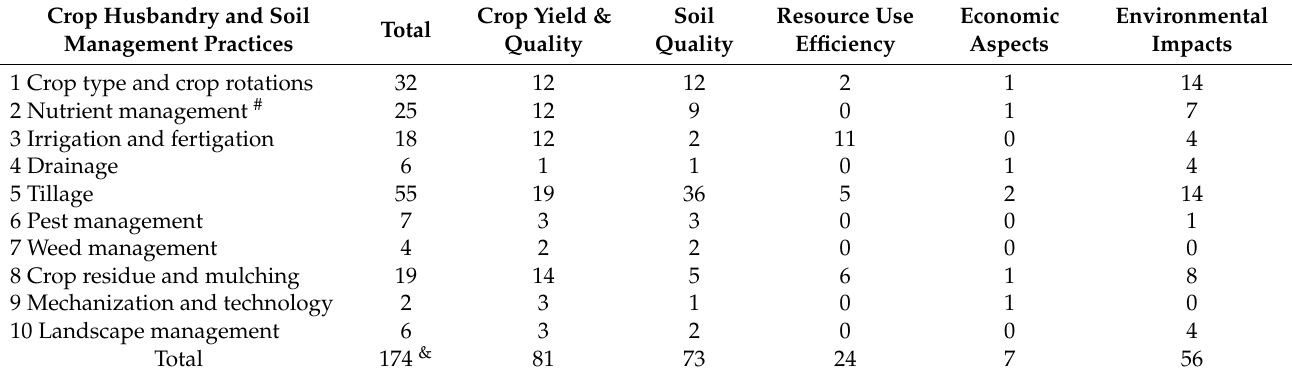
Table 1. Summary of the number of reviewed meta-analysis studies across crop husbandry and soil management practices, and across aspects (outcome). Note that the sum of the studies for the different aspects can be larger than the number of meta-analysis studies since some studies reported on several